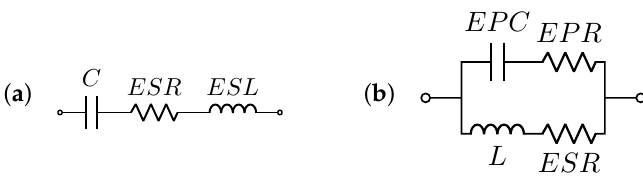
Figure 5. The equivalent circuit of ( a ) capacitor ( b ) inductor.